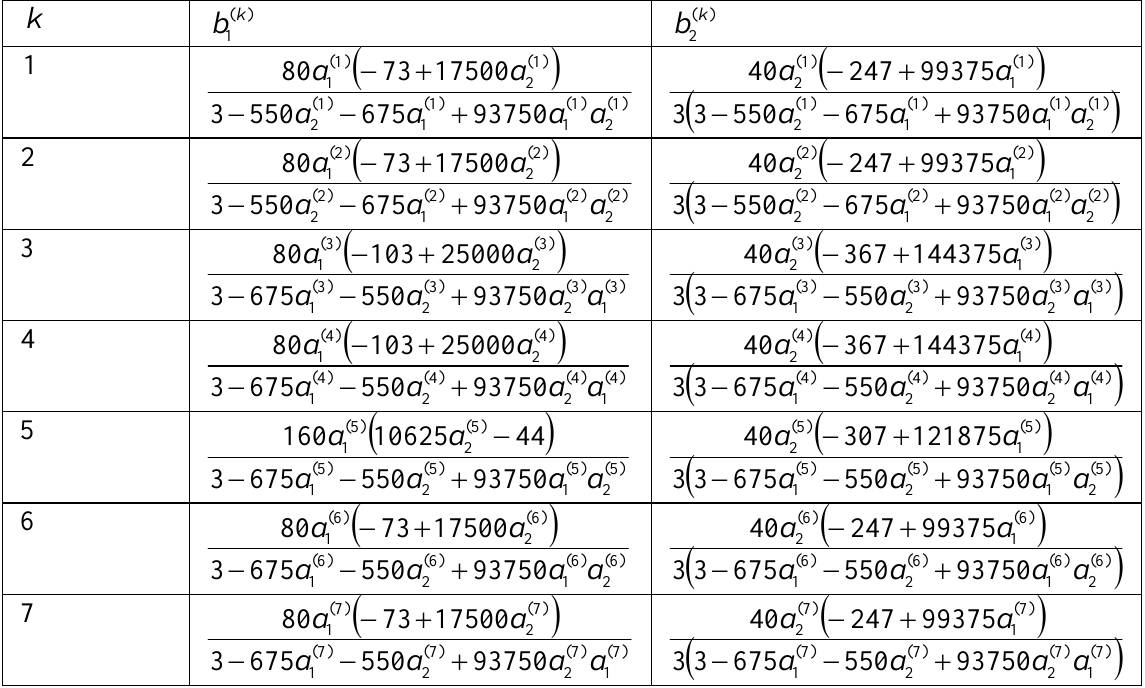
Table 4. Coefficient of linear toll functions yielding local maximum of the total toll